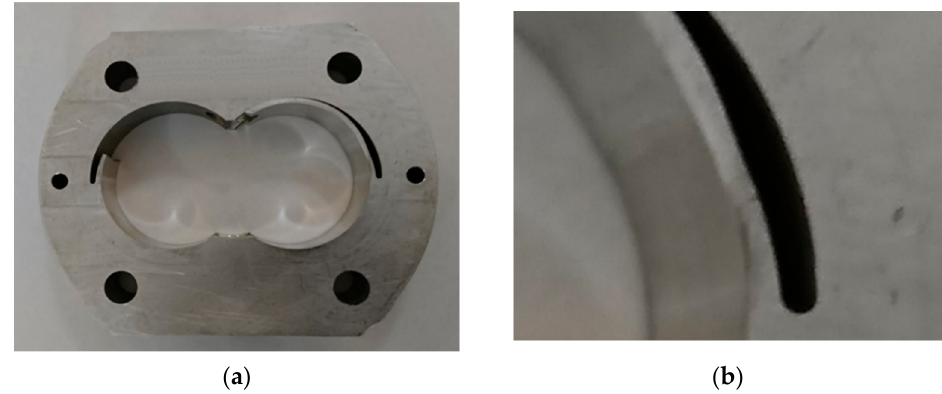
Figure 3. Inner casing in first version of circumferential compensation: ( a ) after durability tests, ( b ) view of narrowing in compensating lip cross section [11].